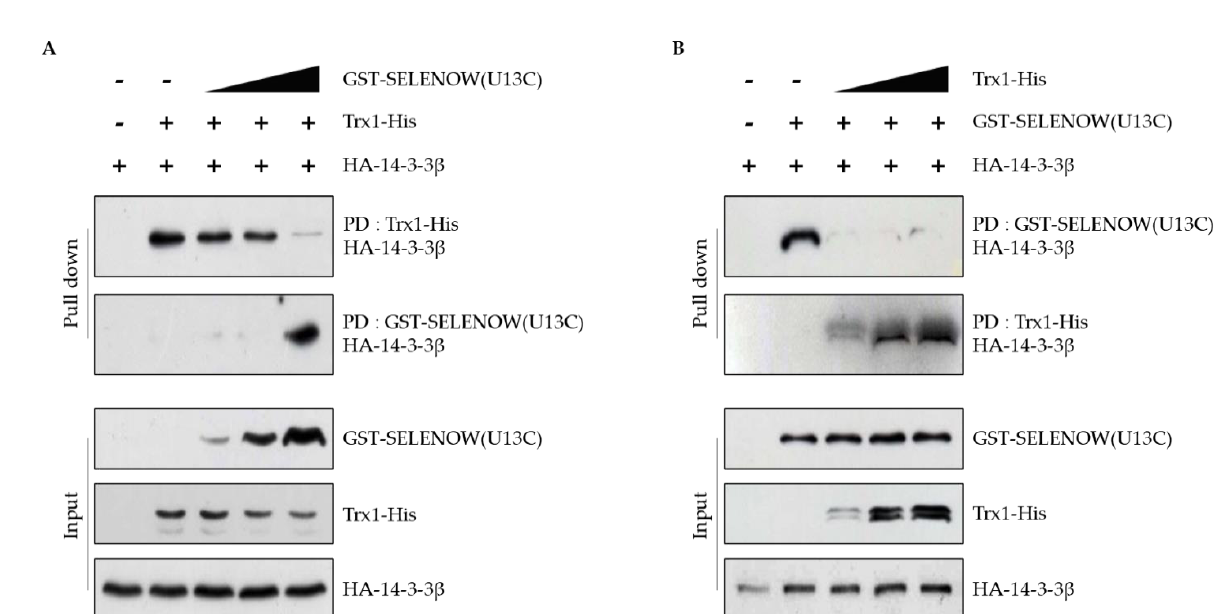
Figure 3. The interaction of Trx1 and SELENOW with 14-3- 3β protein is competitive. ( A ) The mixture of purified Trx1-His protein (5 μg) and cell lysates overexpressing HA -14-3- 3β (5 μg) was incubated with 0, 1, 2, or 5 μg GST -SELENOW(U13C) for 2 h. The mixtures were then incubated with glutathione or Ni-NTA beads for 1 h. The proteins were separated using non-reducing SDS-PAGE. The separated proteins were immunoblotted with anti-HA antibody. ( B ) The mixture of purified GST- SELENOW(U13C) protein (5 μg) and cell lysates overexpressing HA -14-3- 3β (5 μ g) was incubated with 0, 1, 2, or 5 μg Trx1 -His for 2 h. The mixtures were incubated with glutathione or Ni-NTA beads for 1 h. The proteins were separated using non-reducing SDS-PAGE. The separated proteins were immunoblotted with anti-HA antibody.